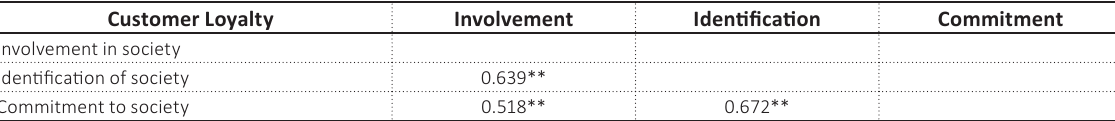
Table 4. Pearson correlation of loyalty to society-related causes